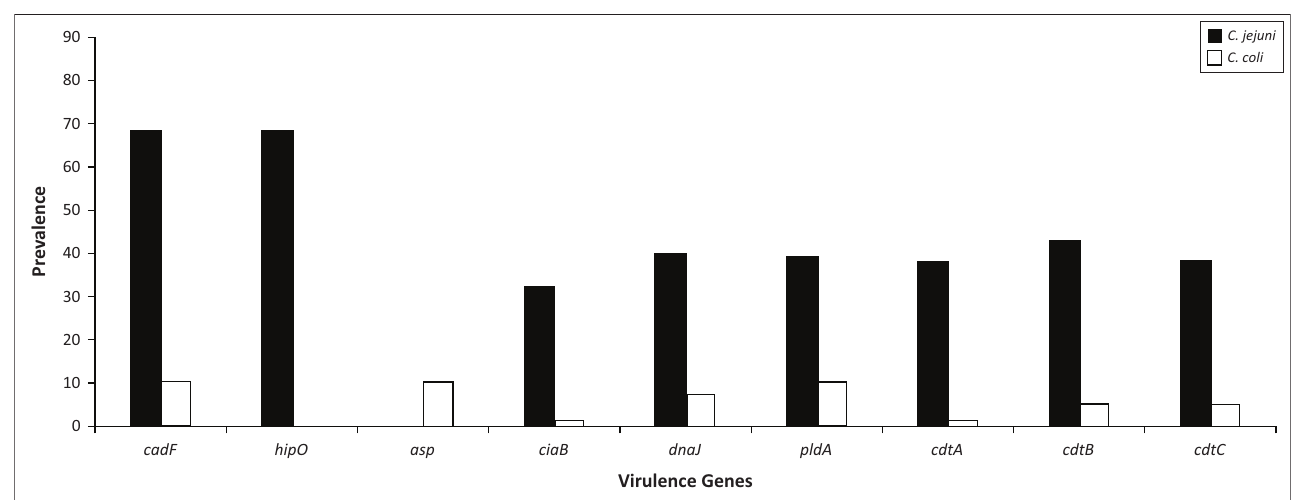
C. jejuni C. coli